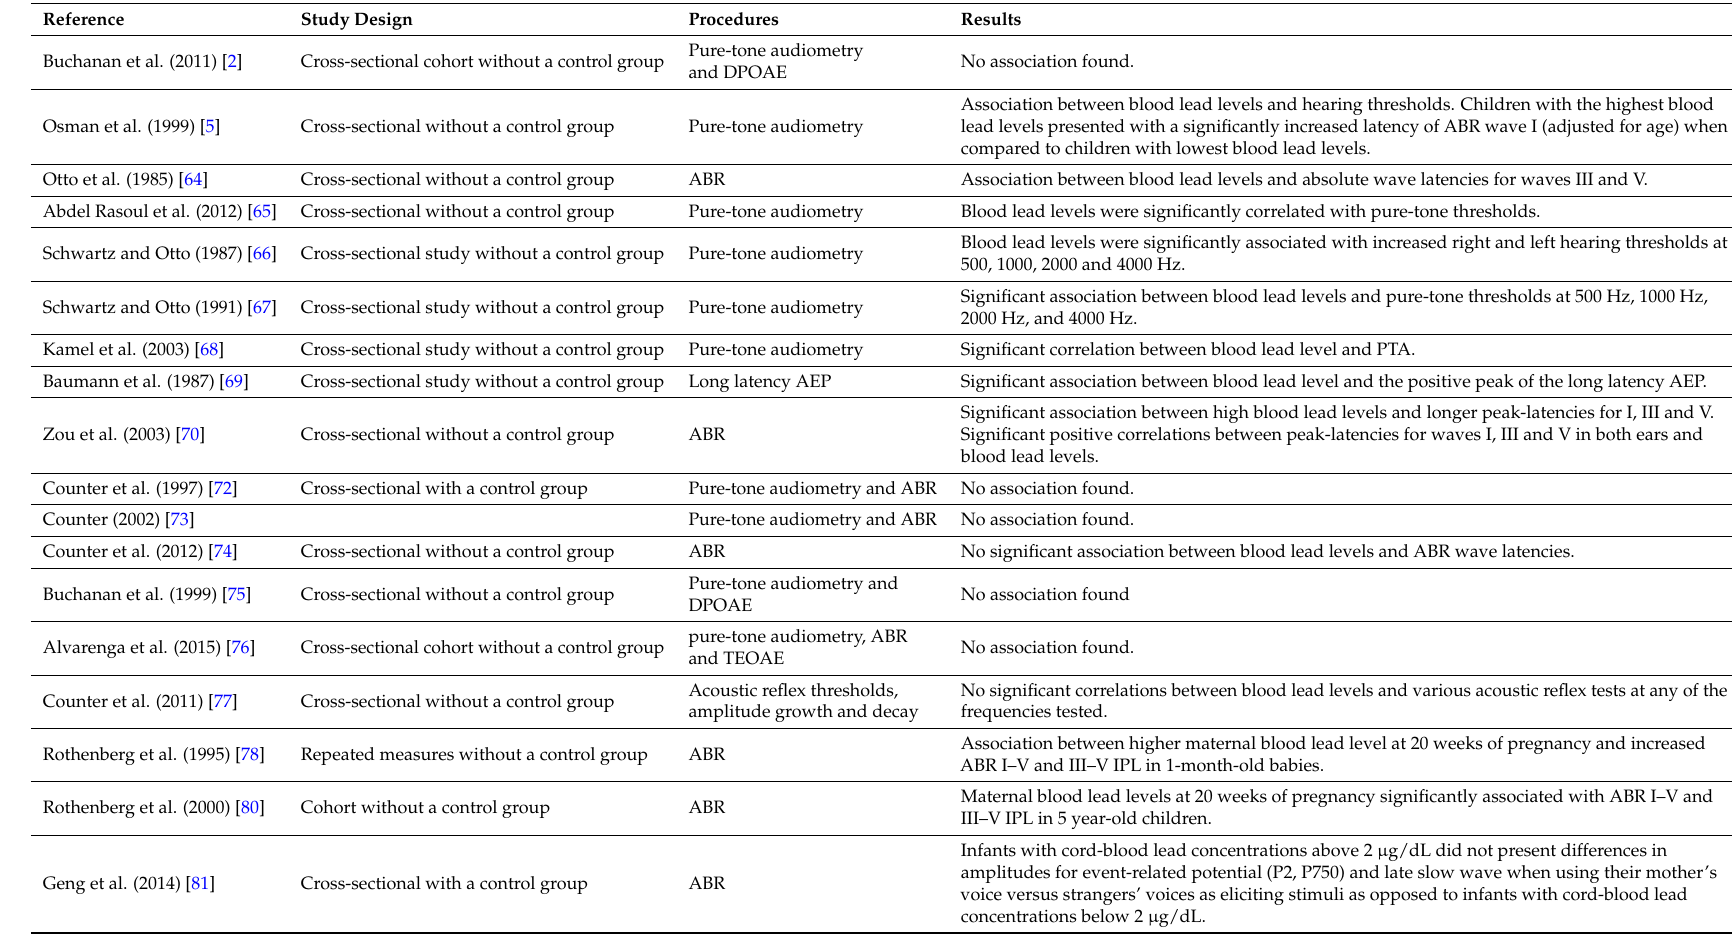
Table 3. Summary of studies investigating the effect of lead exposure in